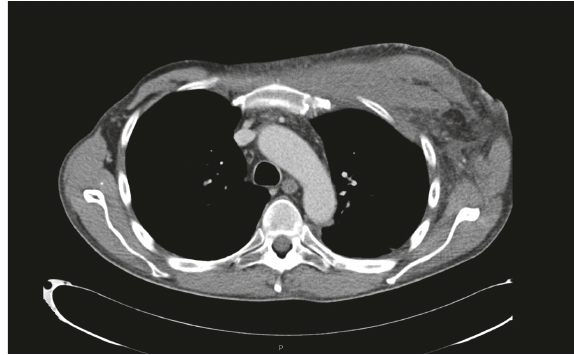
Figure 2: Thoracic Computed Tomography performed in the emergency department.